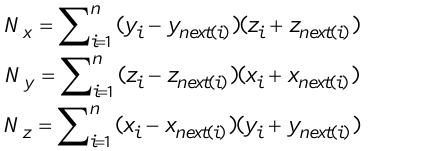
Figure 5. Elimination of the polygon B lies on the back side of the perspective plane. The portion of the polygon C that lies on the back side of the plane is eliminated.